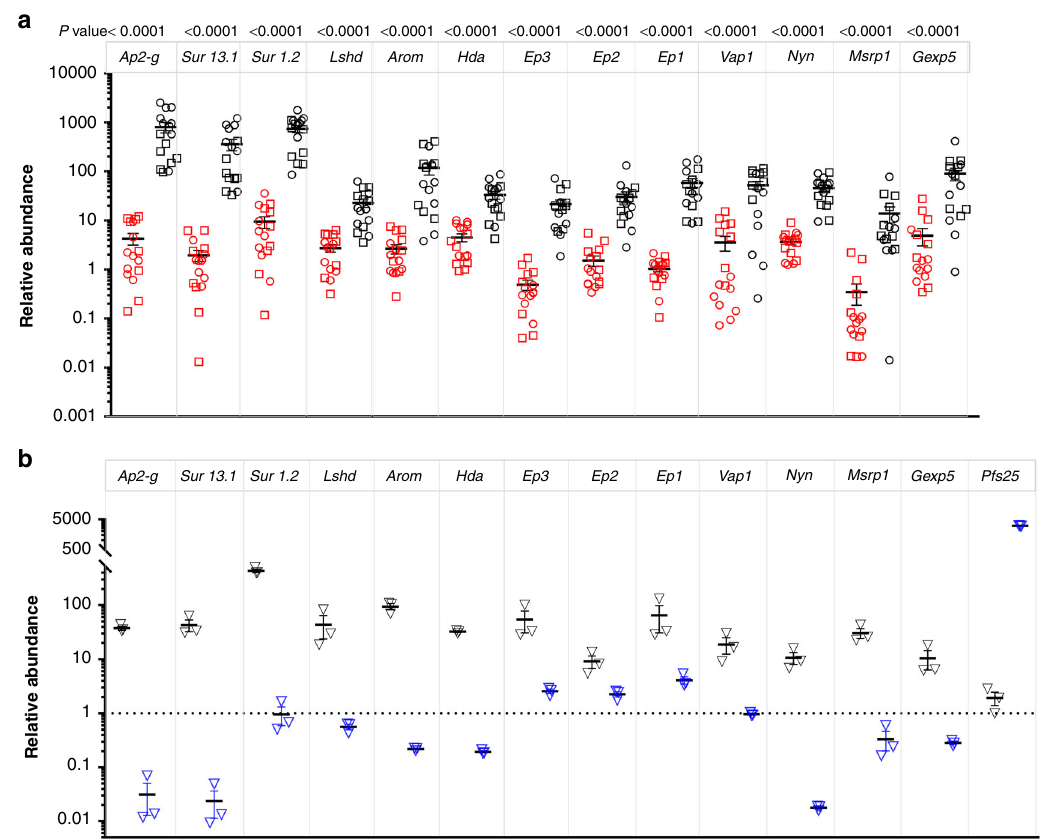
Fig. 3 Validation of the differential expression of the genes in H- and L-GCR samples. a RNA levels of 13 genes were evaluated in an additional 32 day (D)0 blood samples from 2016 (circle) and 2017 (square) with high (H, black) and low (L, red) ex vivo D8 gametocyte-conversion rates (GCR). Differences between the biologically independent H- ( n = 16) and L- ( n = 16) GCR samples were analyzed using a two-sided Mann – Whitney test, and the P value indicated. The mean and standard error of the mean (SEM) are shown. b Transcript abundance in ring stage E5.ap2-g.dd + Shield 1 (Shld1) parasites (black triangle) and mature NF54 gametocytes (blue triangle). Pfs25 transcript abundance was the control for mature gametocytes, and sbp1 and pf18s rRNA were used as endogenous controls for ring stages and mature gametocytes, respectively. RNA from E5.ap2-g.dd ( − Shld1) ring-stage parasites was used as the reference. The mean and SEM from n = 3 biologically independent samples are indicated. Source data are provided as a Source Data fi